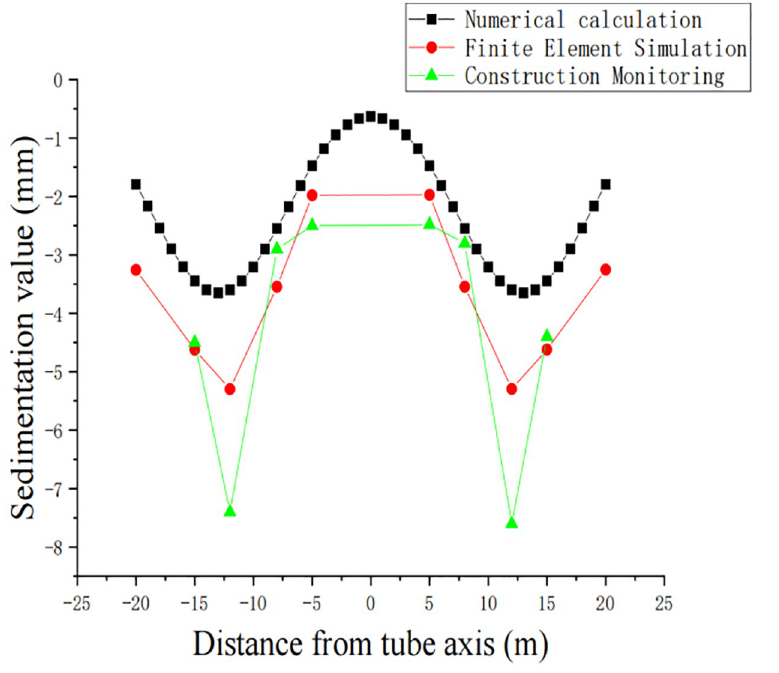
Fig 8. Comparison of the settlement curves of the three